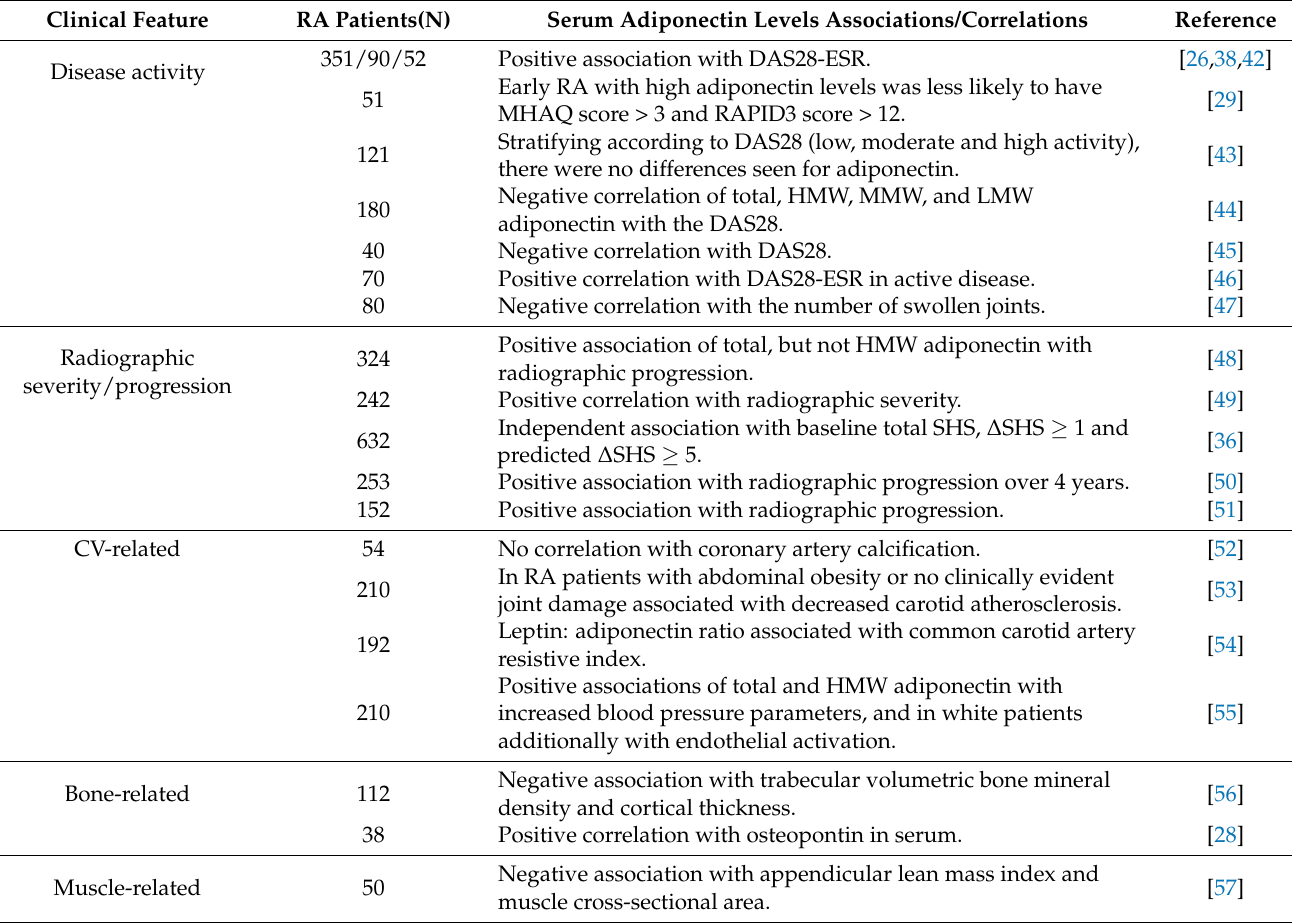
Table 1. Clinical observations associated with circulating adiponectin levels in RA patients. Clinical Feature RA